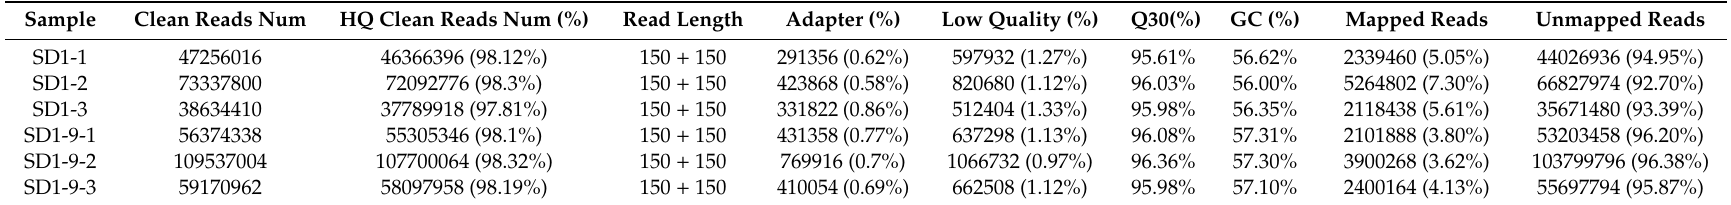
Table 3. Summary of the quality of transcriptomic sequencing data of P. capsici